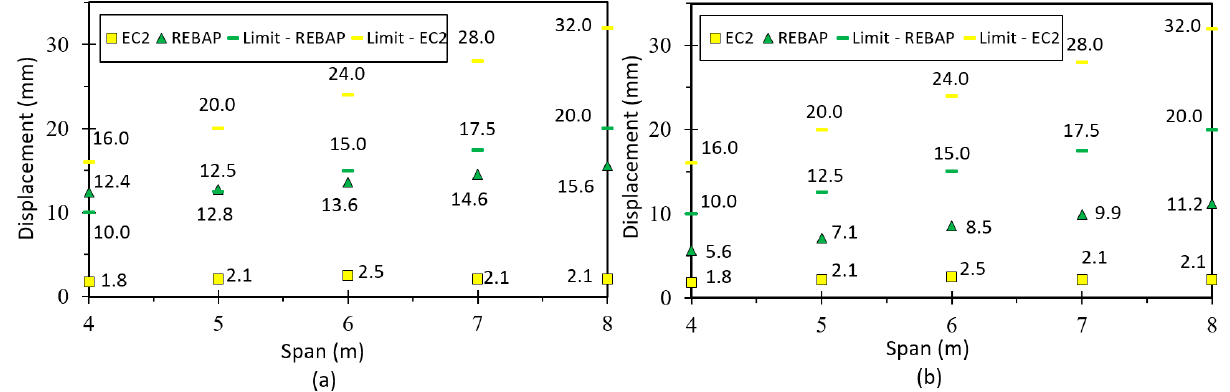
Figure 23. Deformation values of 2NLM: ( a ) analytical and ( b ) numerical, with their limit values, for fixed-ended slab